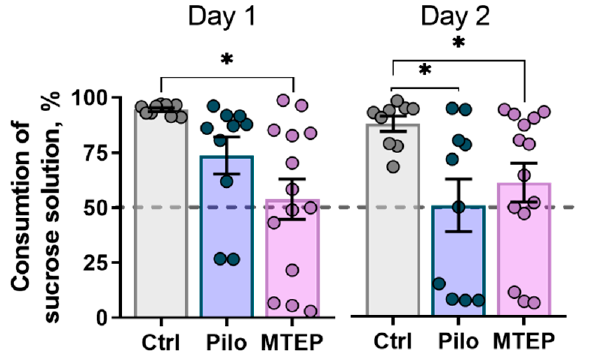
Figure 10. Sucrose solution consumption in a sucrose preference test. Welch ANOVA was used for statistical analysis–Day 1: F 2,14 . 4 = 12.3, p < 0.001; Day 2: F 2,16 . 6 = 7.4, p < 0.01. The circles show individual values. The columns indicate average values and error bars show standard errors of the means. Asterisks indicate differences between groups according to Games–Howell post hoc test: * p <